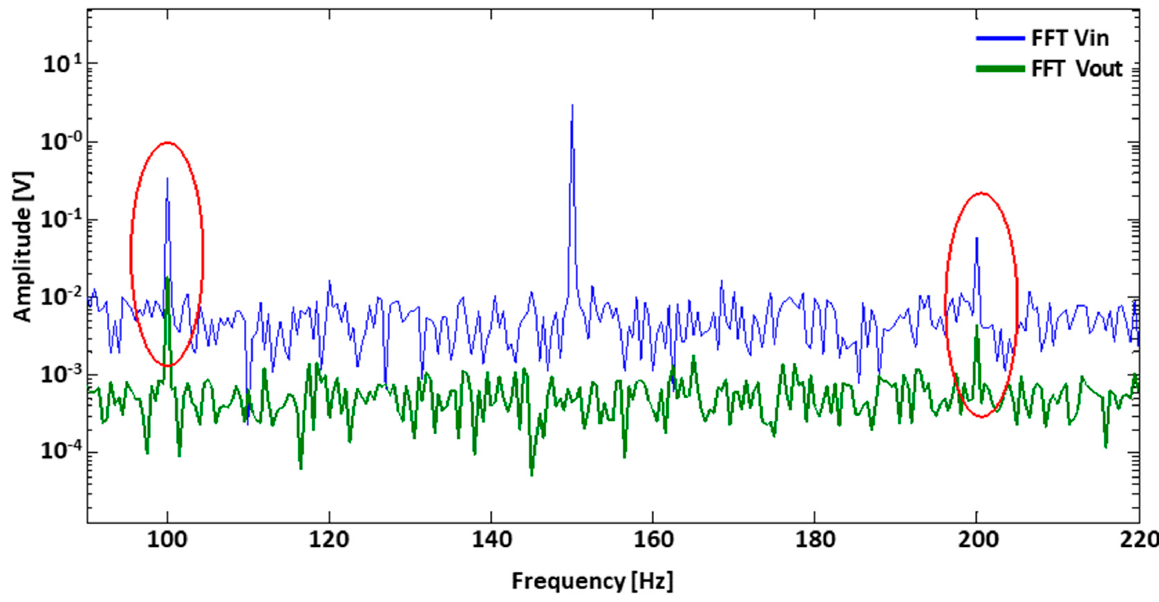
Figure 11. Link between harmonics of voltage on AC ( Vin ) and DC ( Vout ) sides.